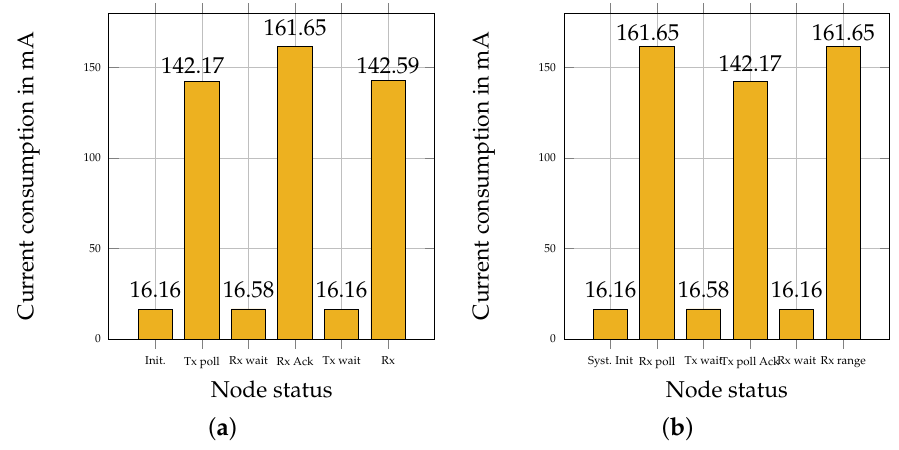
Figure 7. Current consumption over node’s status change in case of ( a ) tag and ( b )